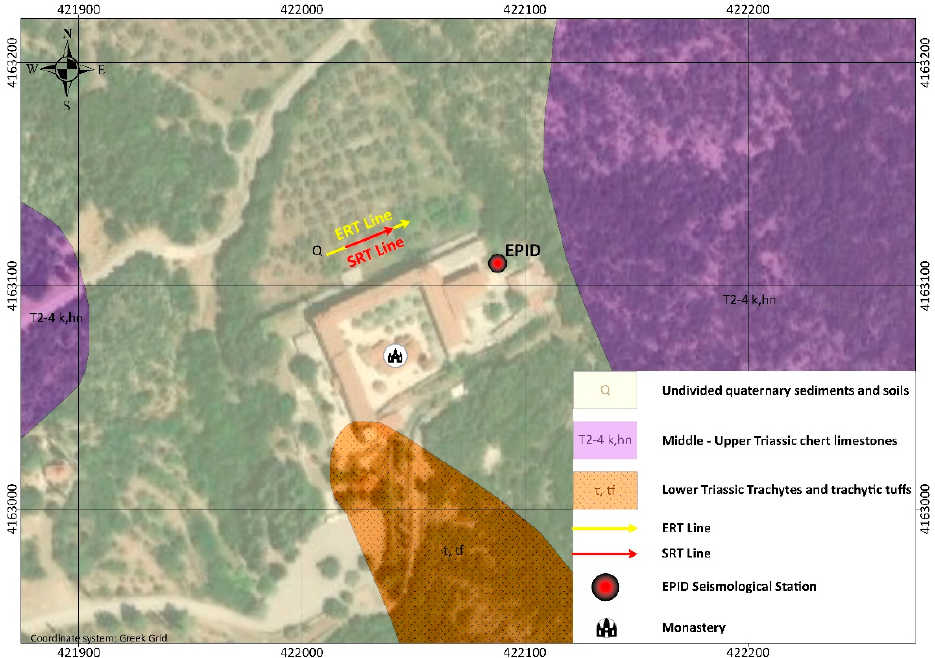
Figure 18. Location of the seismological station EPID and the geophysical measurements along with the geology of the area.